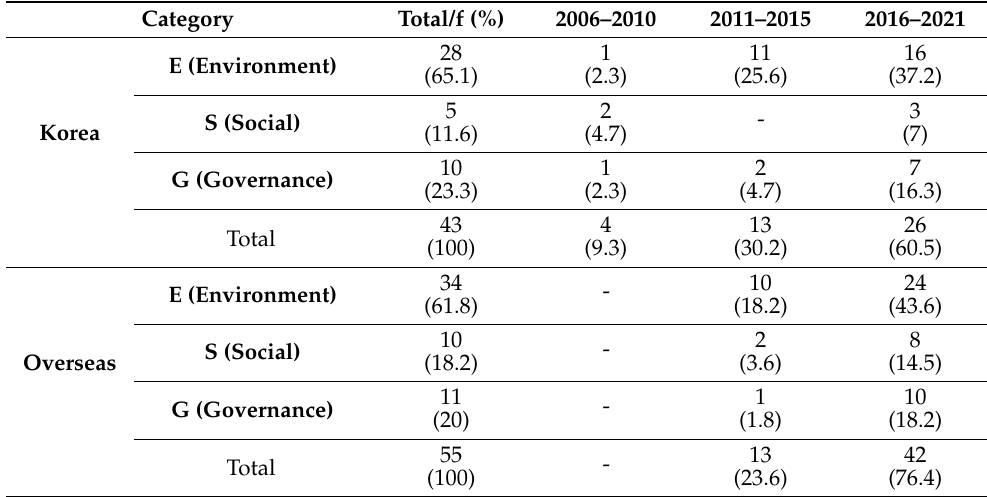
Table 3. Domestic and foreign ESG evaluation